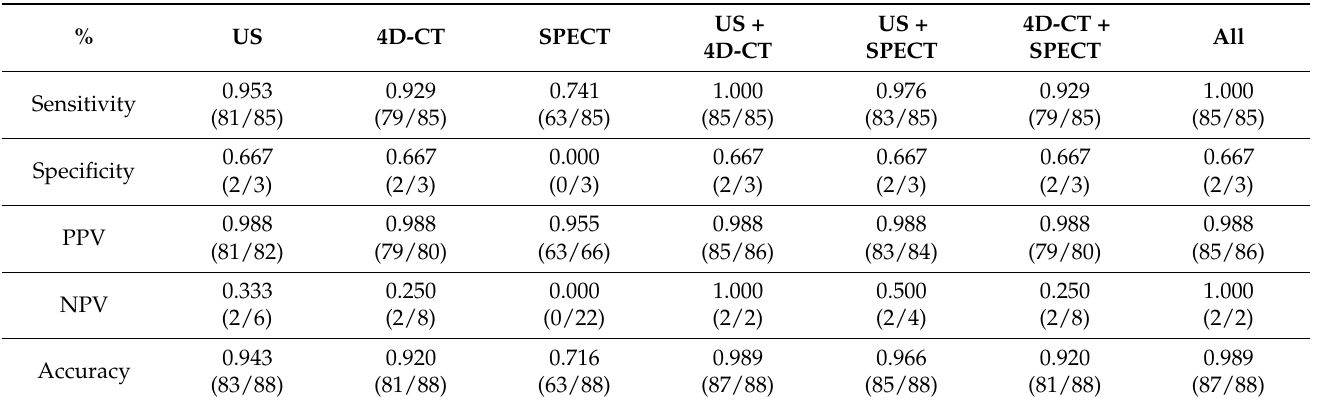
Table 3. Diagnostic Accuracy of Imaging Modalities Analyzed by Lesion (All